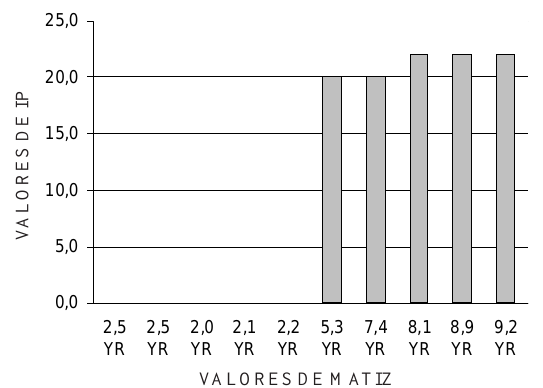
Figura 2. Cinco casos extremos de valores de IP relacionados com valores de matiz observados no conjunto de amostras de solos. Valores de IP ocorridos no intervalo de matiz entre 2,0 e 2,5YR (IP igual a 0) e matiz entre 5,3 e 9,2YR (IP entre 20 e